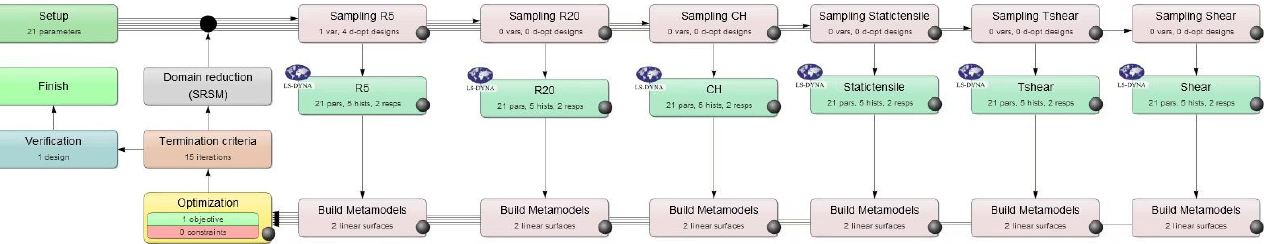
Figure 7. LS-OPT scheme for GISSMO calibration.